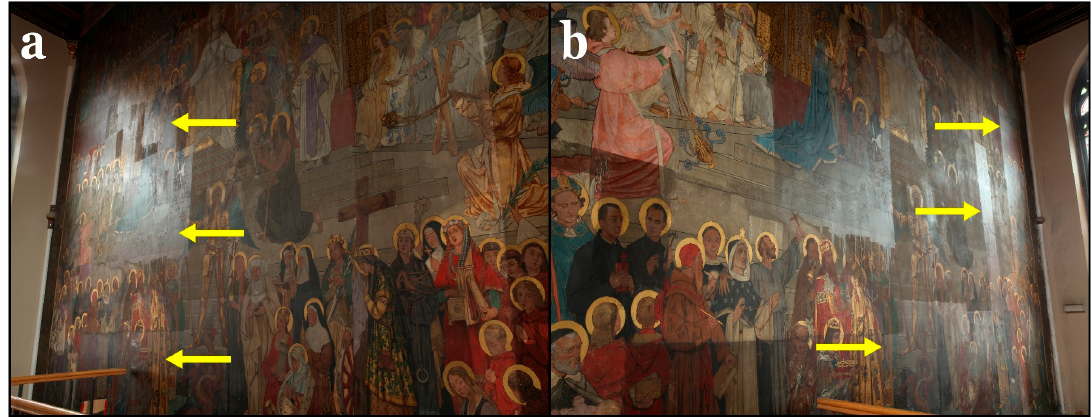
Figure 4. Photographs showing the glossy varnish that was not applied to the entire wall painting, as indicated by the yellow arrows. ( a ) Left side and ( b ) right side of the wall